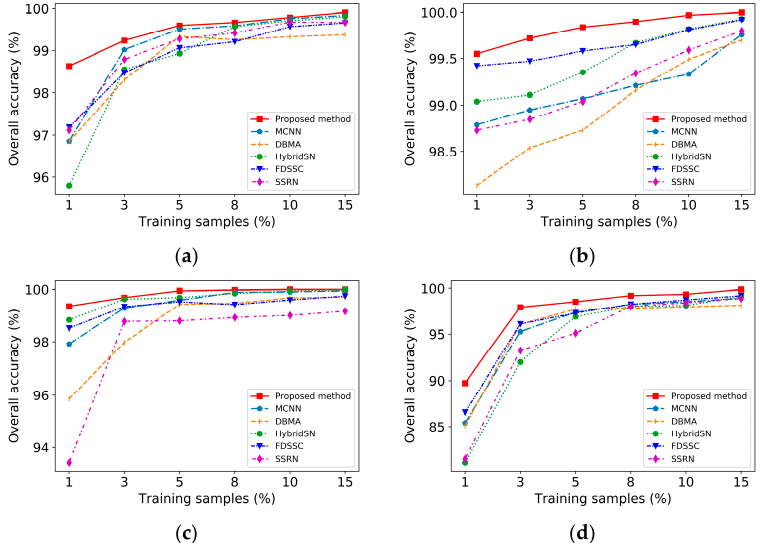
Figure 10. OA results of the six methods with different numbers of training samples. ( a ) PU, ( b ) PC, ( c ) SA, and ( d ) HU. ( c ) SA, and ( d )